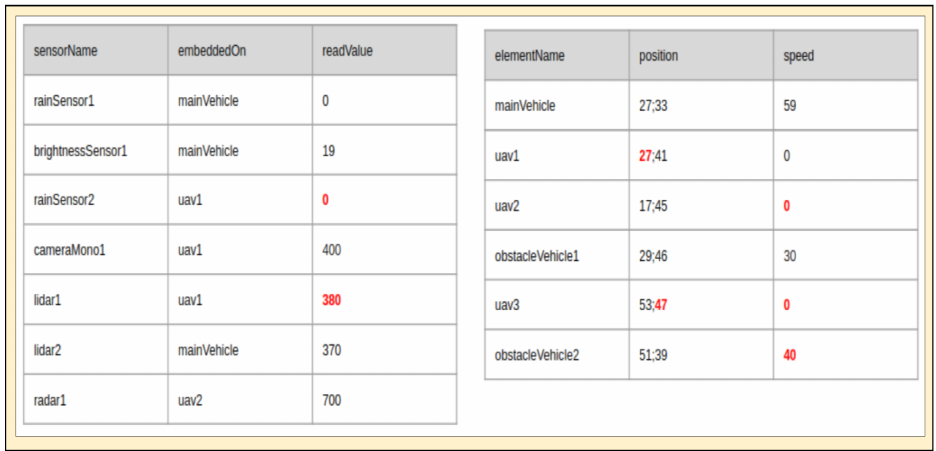
Figure 28. Data set after the completion process (x in red are now replaced by actual values).